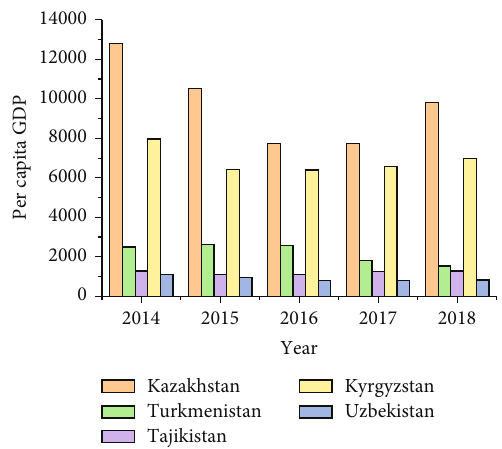
Figure 1: Distribution map of per capita GDP of fi ve Central Asian countries from 2014 to